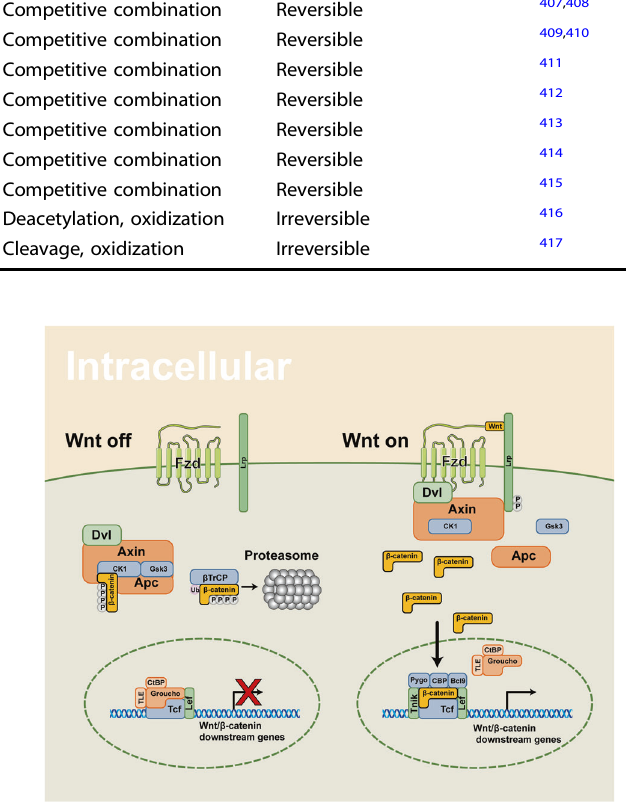
Fig. 3 The intracellular components and signaling transduction of Wnt/ β -catenin